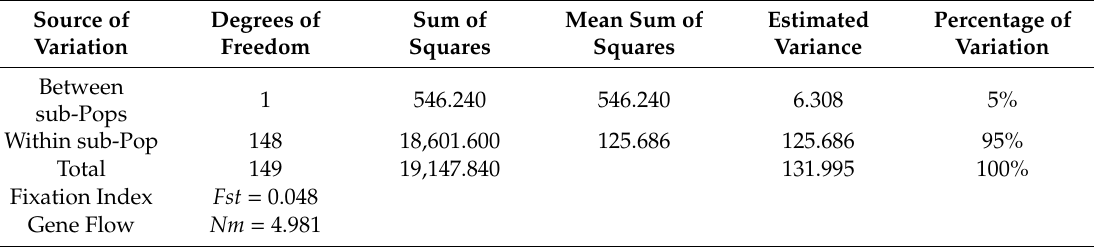
Table 5. Analysis of molecular variance (AMOVA) of SSR-based genetic variation between and within two sub-populations of Pop1 and